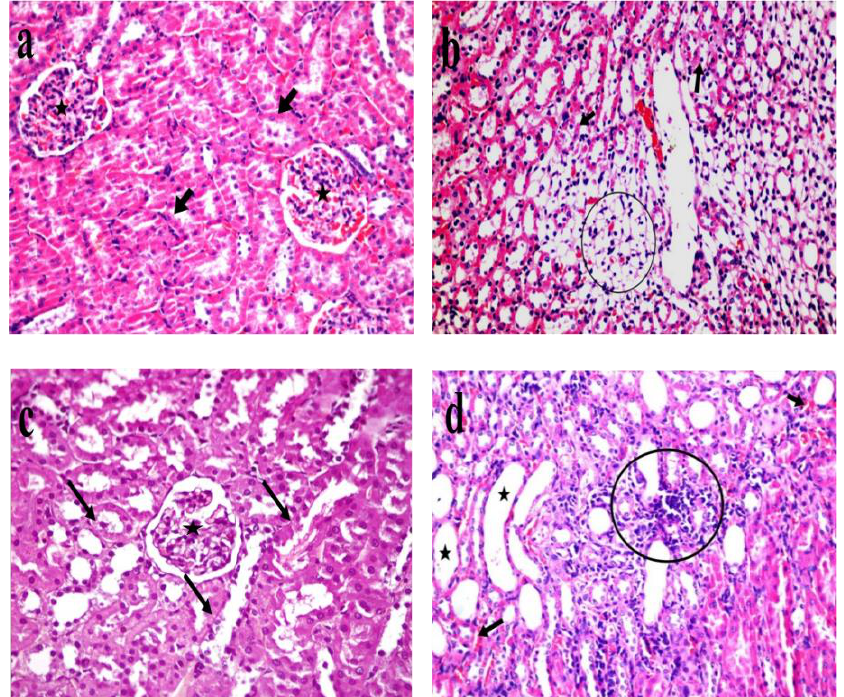
Figure 4. Representative photomicrographs of rat kidneys. ( a ) Group 1, negative control: normal renal tubules (arrows) and glomeruli (stars). ( b ) Group 2, positive control: degeneration collected tubules (circle) with desquamated lining epithelium (arrows). ( c ) Group 3, plain yogurt (10 g/day): vacuolation of the glomerular epithelium (arrow) and focally distributed degeneration of some renal tubules (star). ( d ) Group 4, yogurt with 0.4% aqueous Hawthorn leaf extract (10 g/day): focal interstitial lymphocytic infiltrations (circle), cystic dilated renal tubules (stars), and slightly congested interstitial capillaries (arrows). Hematoxylin and eosin staining, magnification × 400.